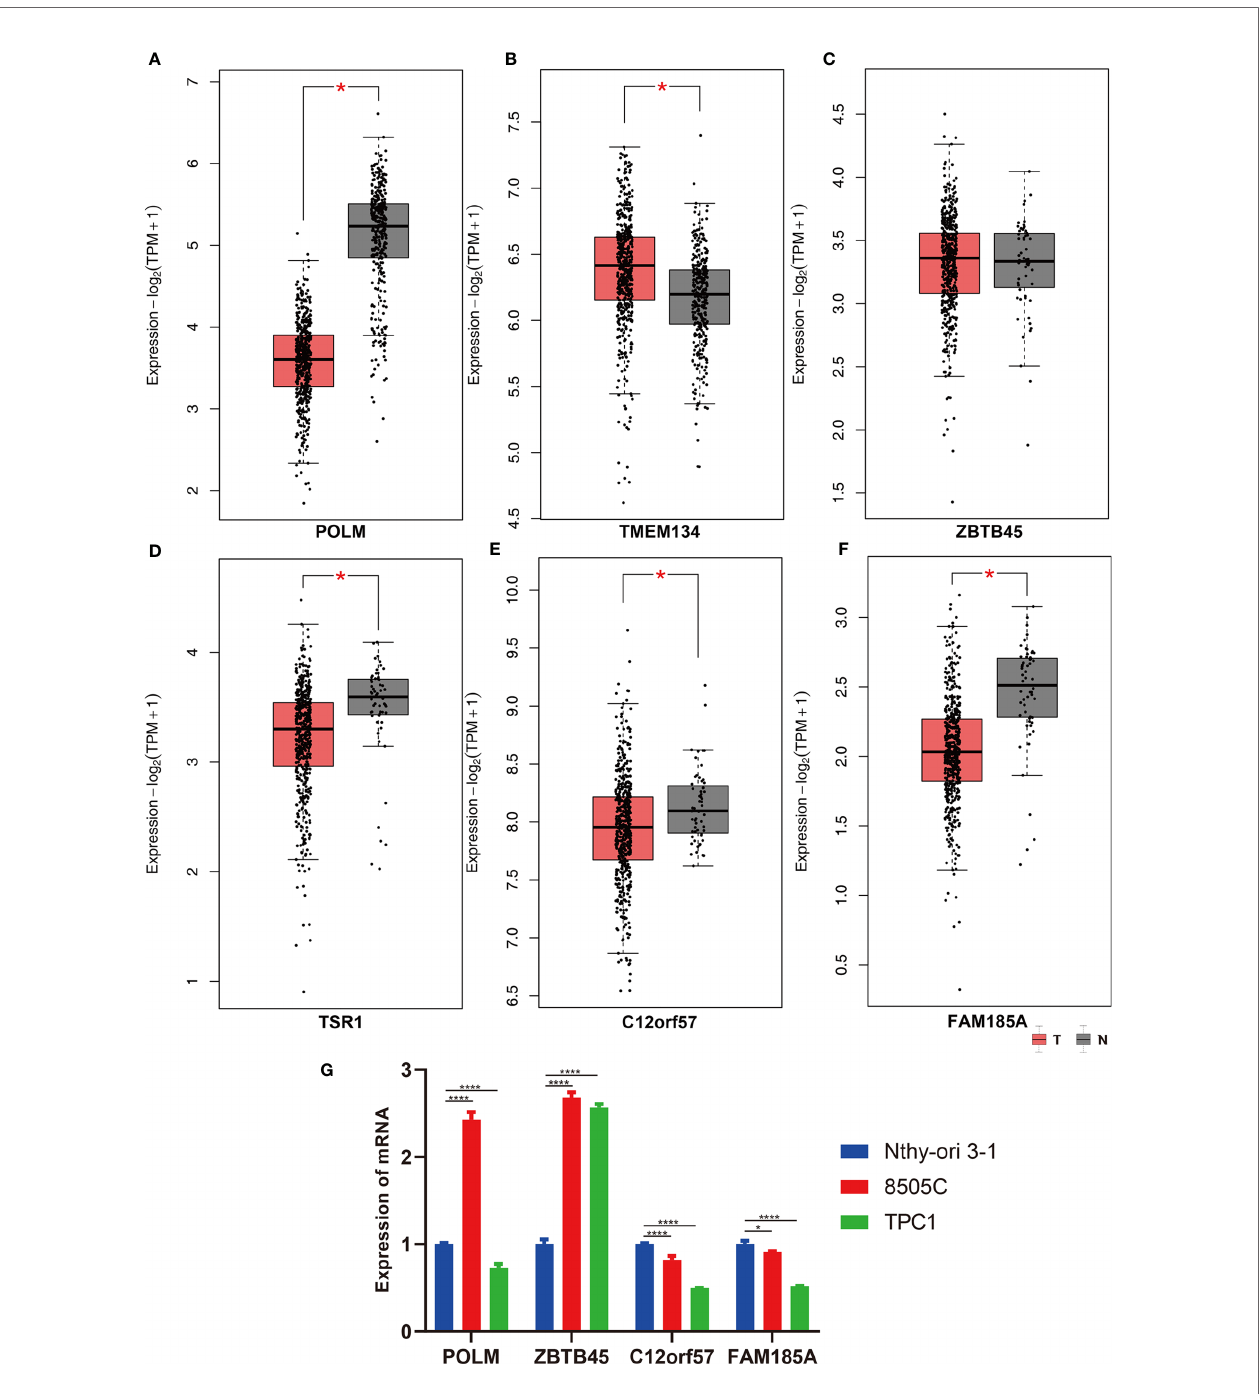
FIGURE 8 | The validation of screened genes in the fi nal prediction model. The expression difference of (A) POLM, (B) TMEM134, (C) ZBTB45, (D) TSR1, (E) C12orf57, (F) FAM185A between THCA and Control in GPEIA2 database. (G) The relative mRNA expression of screened genes was evaluated by qRT-PCR. *p < 0.05; ****p <